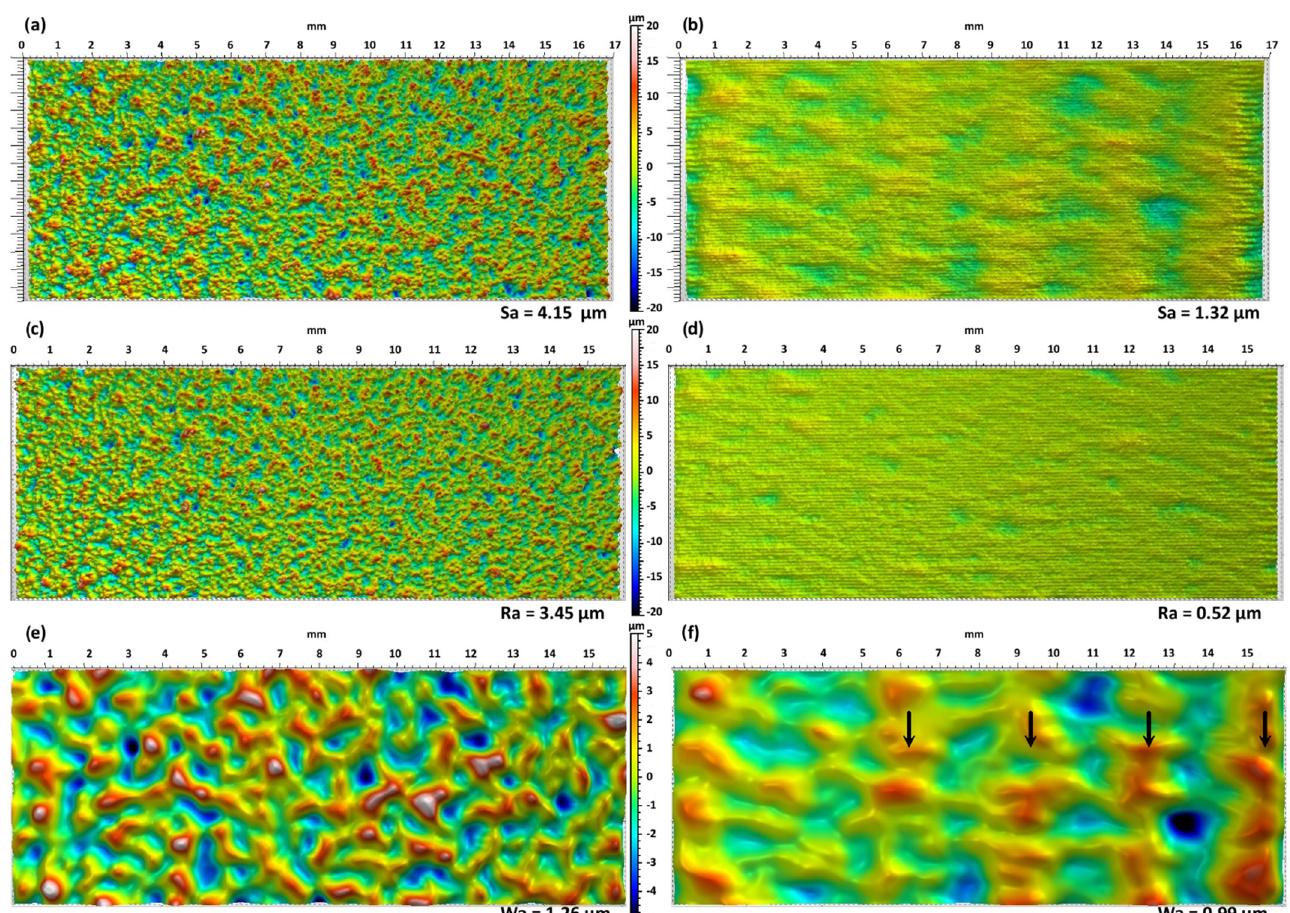
Figure 12. Topography measurement for the test Otpim 6 before (left-hand side) and after (right-hand side) LP. ( a , b ) show the unfiltered filtered ( Sa ), ( c , d ) show only the roughness of the surface with a cut-off of 0.8 mm ( Ra ) ( e , f ) show only the waviness of the surface with a cut-off of 0.8 mm ( Wa ). For each line, the vertical color scale is the same in order to compare the surfaces and is indicated in the middle.